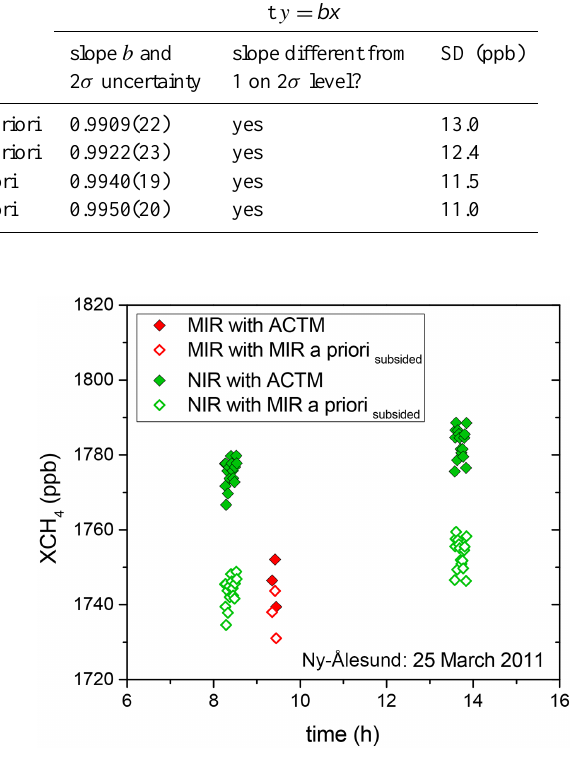
Figure 4. Ny-Ålesund XCH 4 on 25 March 2011 retrieved from FTIR data. MIR and NIR retrievals are corrected to the common ACTM prior (filled squares) and are corrected to a strongly sub- sided MIR a priori profile (open squares) as shown in Fig.